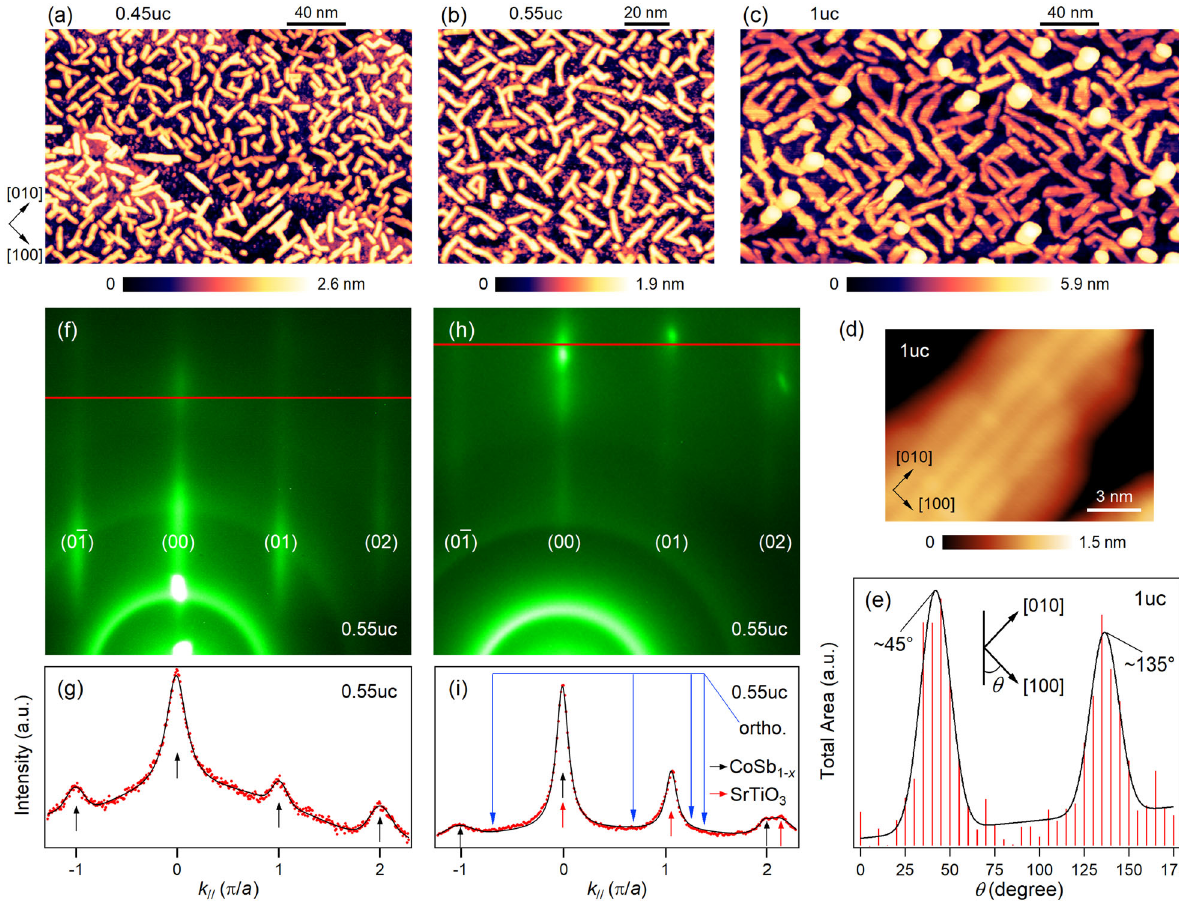
Fig. 1 Surface morphology and in-plane lattice symmetry of CoSb 1 − x nanoribbons. a – c STM topographies of Samples I (0.45 uc), II (0.55 uc), and III (1 uc), respectively, measured with V s = 3 V, I = 30 pA. Clusters of ~4 nm in height form on top of Sample III. d STM image of a [010]- oriented CoSb 1 − x nanoribbon of Sample III ( V s = 3 V, I = 30 pA). e Counted area and orientations of all the nanoribbons in ( c ). The de fi nition of θ is shown in the inset. The black curve is the fi tting result by two Gaussian peaks and a linear background. f , g RHEED image of Sample II with incident beam along the [100] direction and corresponding RHEED intensity curve along the red cut, respectively. h , i Same as ( f , g ) with a larger glancing angle and incident beam slightly off the [100] direction. In ( g , i ), the black curves are the fi tting results by Gaussian peaks and quadratic polynomial backgrounds, and the black and red arrows indicate the diffraction signals from CoSb 1 − x and SrTiO 3 substrate, respectively. a ( = 4.0 Å) is the lattice constant of CoSb 1 − x . The blue arrows represent the anticipated streak positions of the orthorhombic CoSb phase in ref. 13